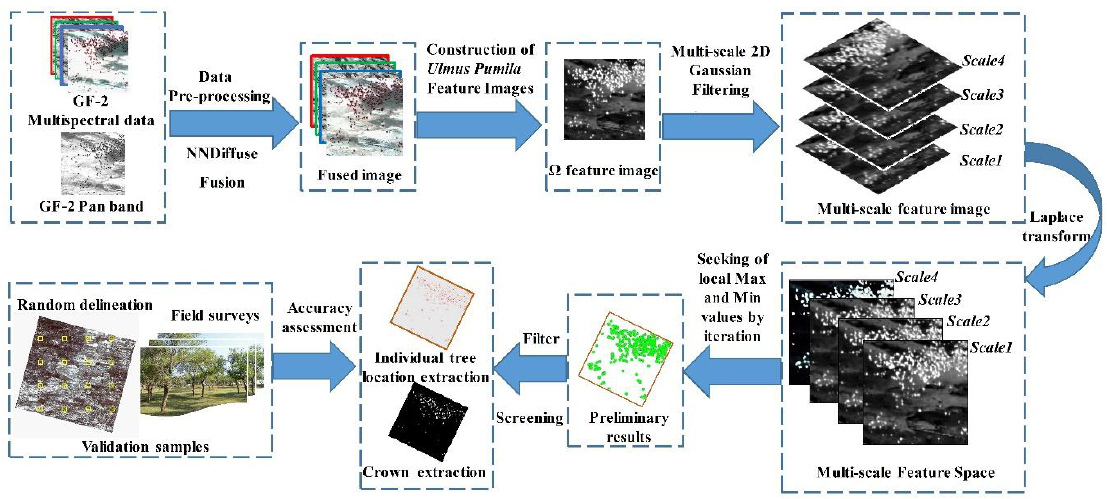
Figure 3. Flowchart of the automated process for extraction of information on sparse Ulmus pumila woodland in the Otingdag Sandy Land.